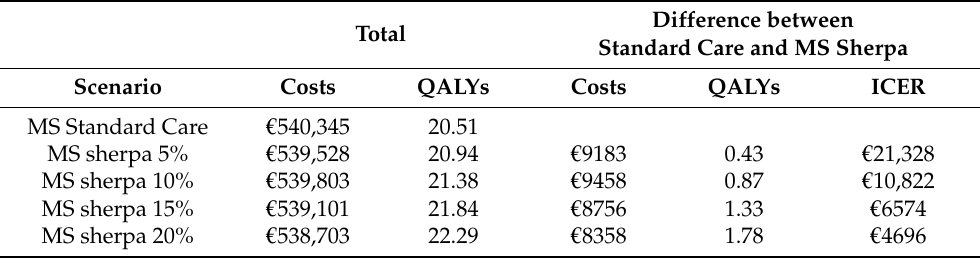
Table 2. Cost-effectiveness results of MS sherpa versus standard care from a health care